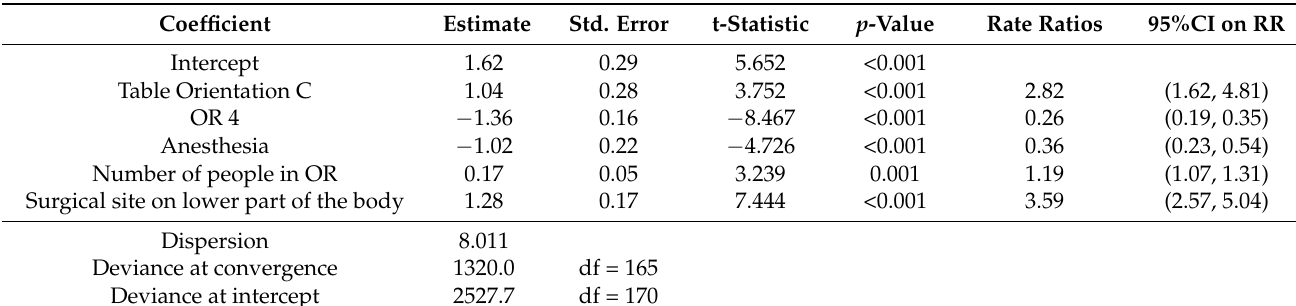
Table 10. Quasi-Poisson regression model predicting the number of contacts for each individual in the OR during the intraoperative phase.